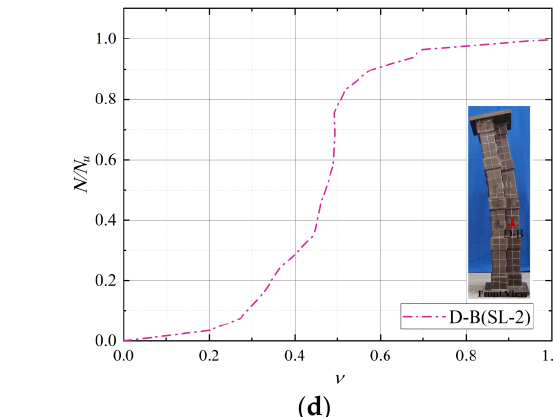
Figure 14. Poisson’s ratio of the steel tube ( a ) A2-T of HL-1; ( b ) B-T of HL-1; ( c ) A2-T of WL-1; ( d ) D-B of HL-2.